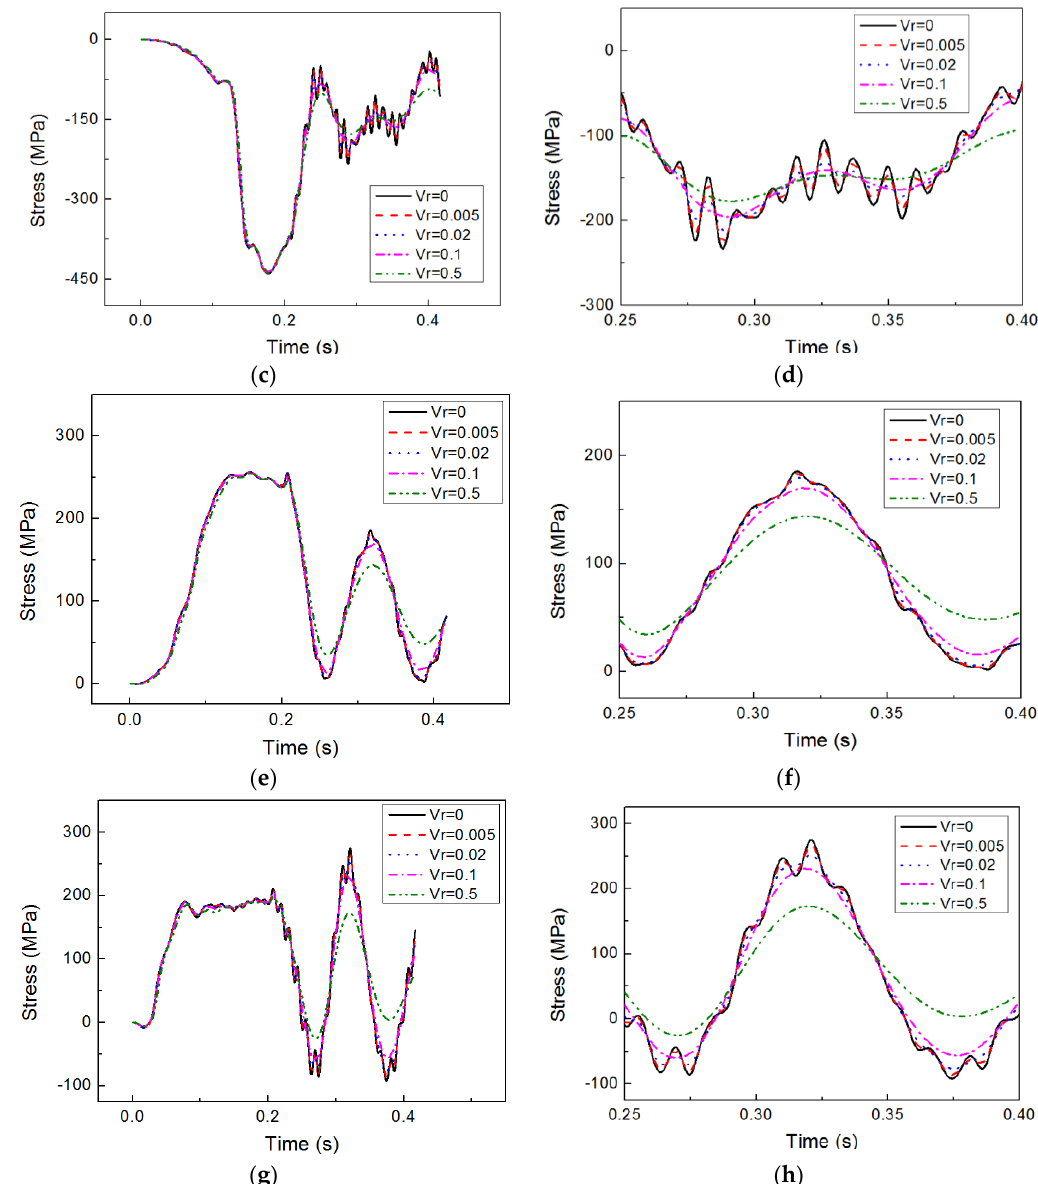
Figure 11. Comparative analysis on the effect of the structural damping. ( a ) entire simulation of S1; ( b ) vibration response of S1 after the flow separation; ( c ) entire simulation of S3; ( d ) vibration response of S3 after the flow separation; ( e ) entire simulation of S5; ( f ) vibration response of S5 after the flow separation ( g ) entire simulation of S7; ( h ) vibration response of S7 after the flow separation.